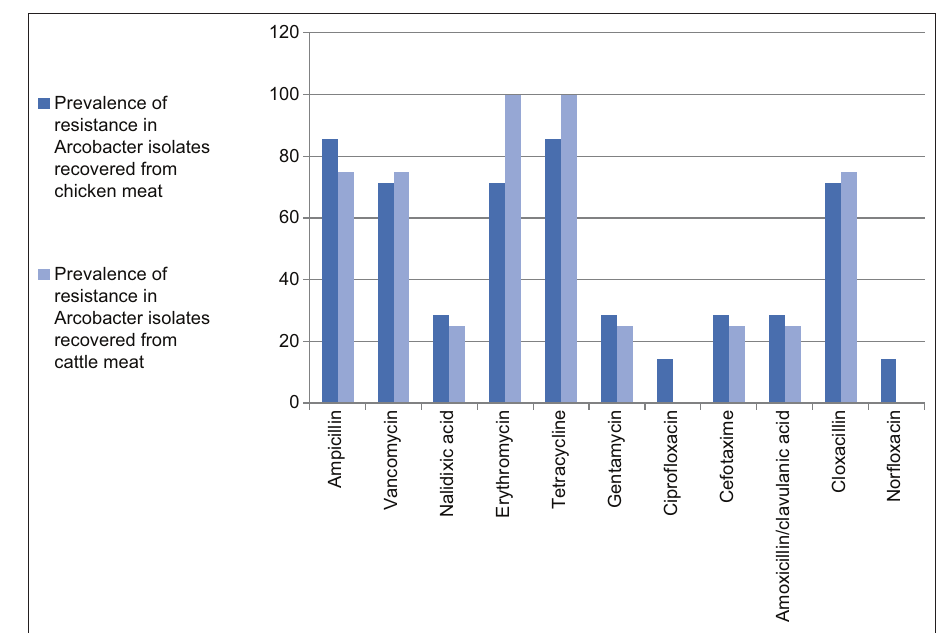
Figure-2: Prevalence of resistance in Arcobacter isolates based on samples